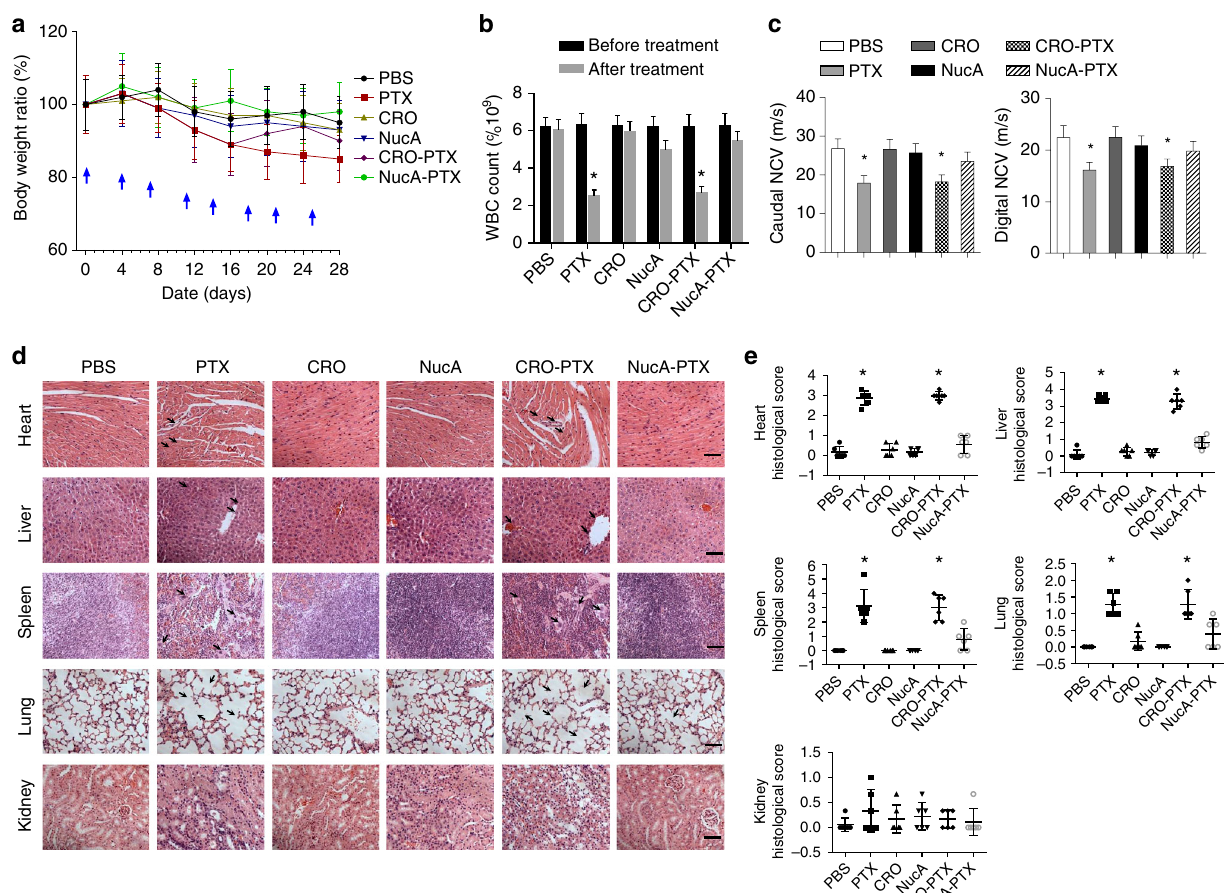
Fig. 8 The effect of NucA modi fi cation on the toxicity of the conjugated PTX. a Body weight changes after 4 weeks of different treatments indicated in xenografted mice. Body weight was normalized to each body weight before treatment. The dosing points were indicated with blue arrows. b The white blood cell count determined by automated hematology analyzer before and after different treatments in xenografted mice. c Neurophysiological analysis of caudal NCV and digital NCV in the xenografted mice 4 days before the end of the different treatments indicated. d Histological assessments of tissues using H&E staining in different treatment groups. Arrows in Heart images indicate the myo fi brillar loss and atrophy of myocardial cells. Arrows in Liver images indicate the hepatic cords loss, steatosis and dilatation of blood sinus. Arrows in Spleen images indicate the white pulp atrophy. Arrows in Lung images indicate the broken lung fi bers. Scale bars, 100 μ m. e Semi-quantitative histological analysis of the H&E-stained tissue sections in different treatment groups. Note: PBS, the xenografted mice treated with PBS. PTX, the xenografted mice treated with paclitaxel. CRO, the xenografted mice treated with CRO aptamer. NucA, the xenografted mice treated with nucleolin aptamer. CRO-PTX, the xenografted mice treated with CRO-PTX. NucA-PTX, the xenografted mice treated with NucA-PTX. The data were presented as the means ± standard deviation. n = 6, * P < 0.05 vs. NucA-PTX